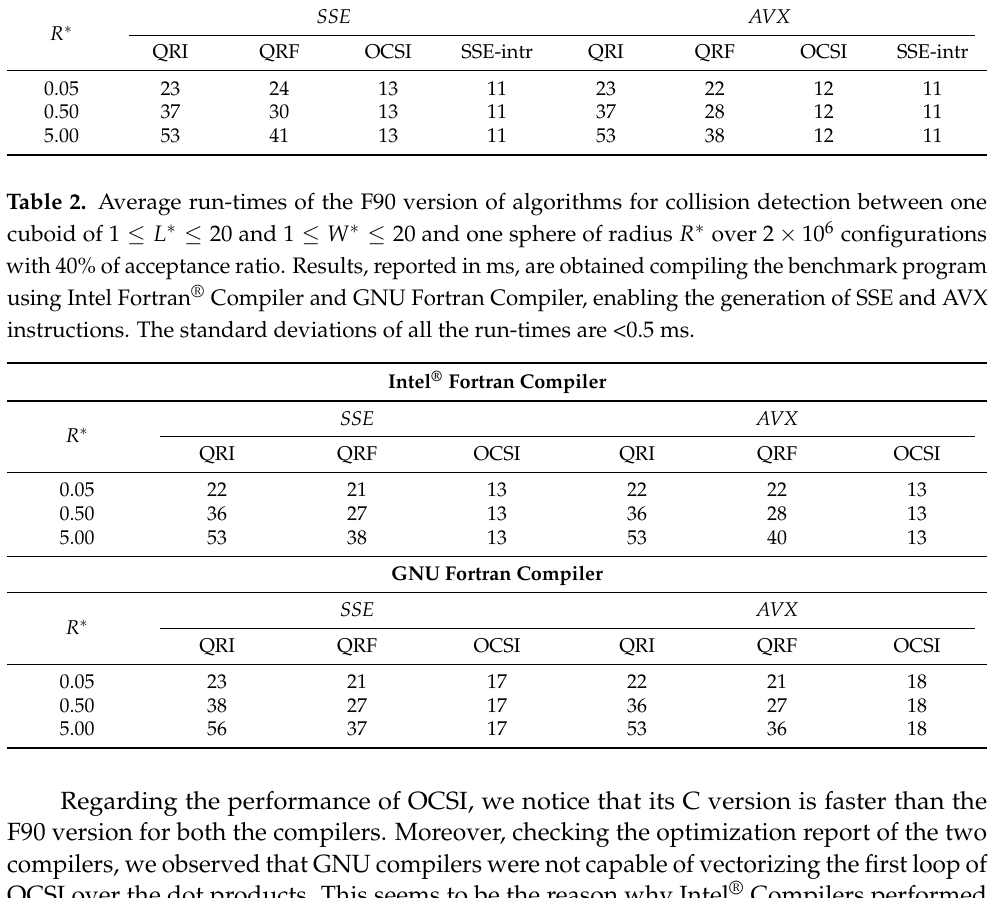
10 6 configurations ×